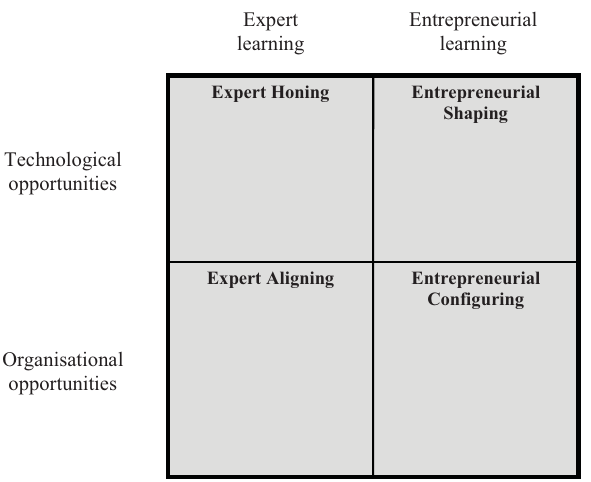
Figure 1: Dynamic capability learning framework